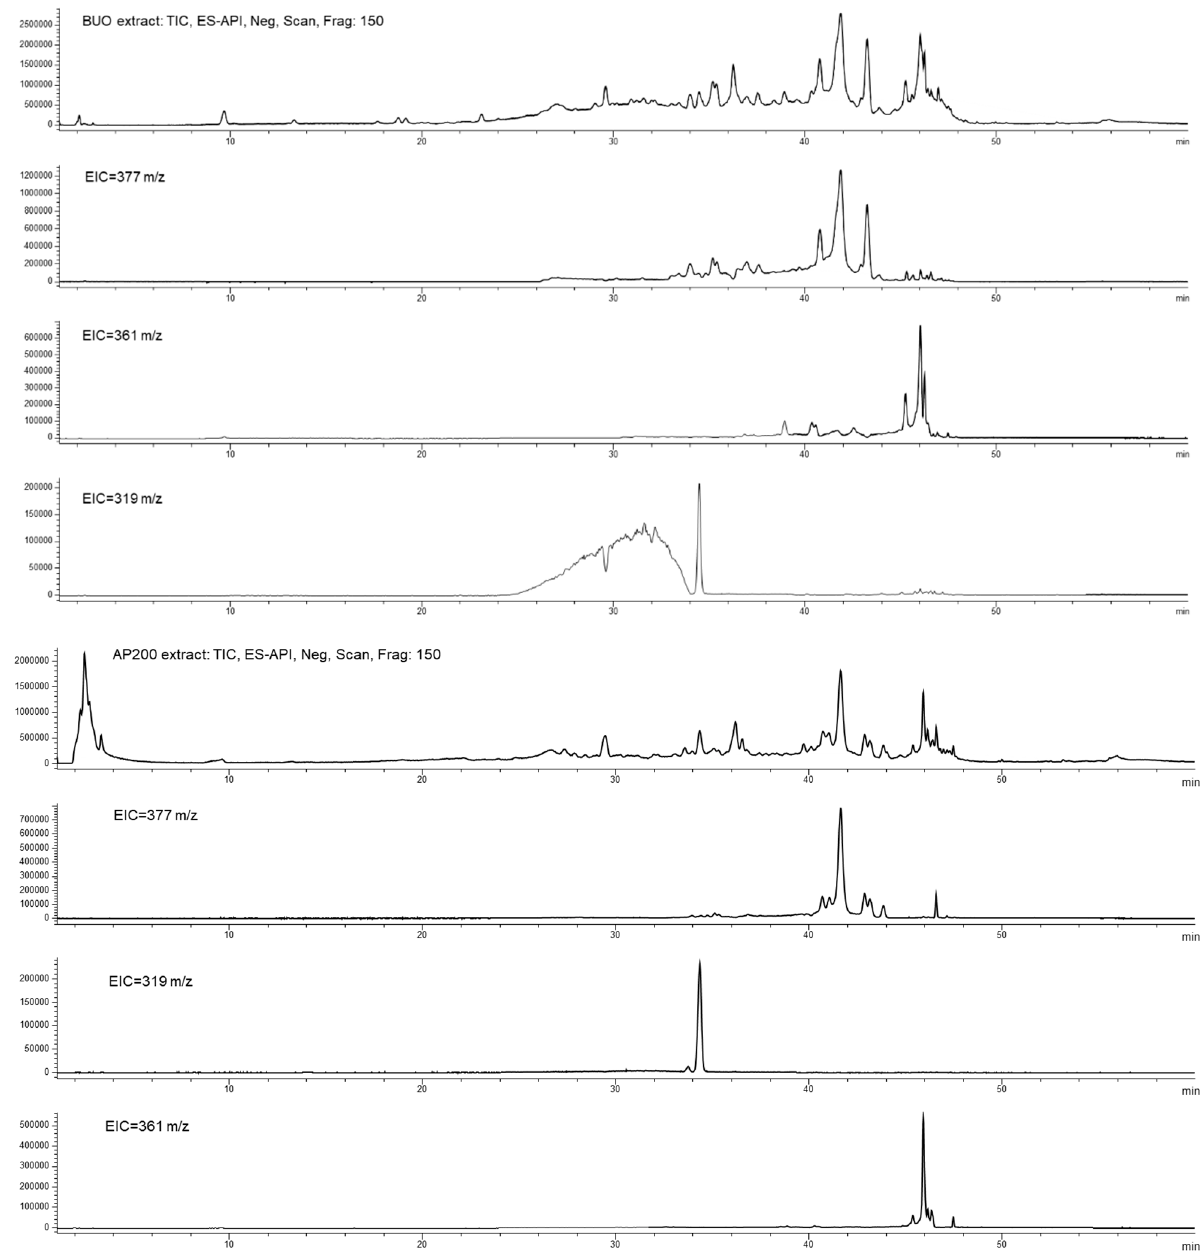
Figure 7. Total ion current (TIC) and extract ion current (IC) profiles of the BUO extract ( top ) and AP200 sample after